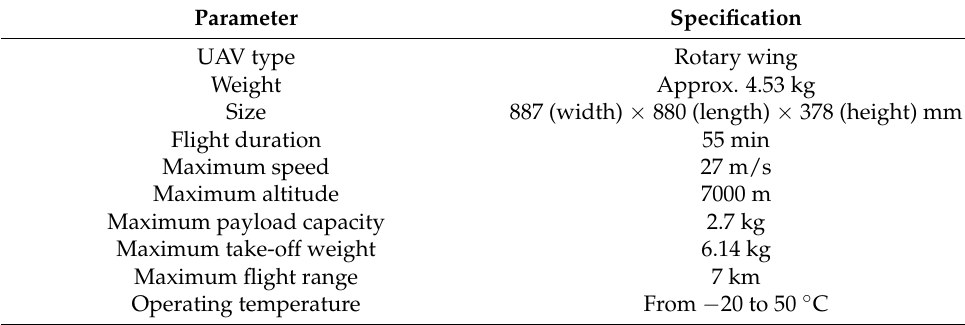
Table 3. List of vegetation indices (VIs) used in the modelling of crop water content and related source references.